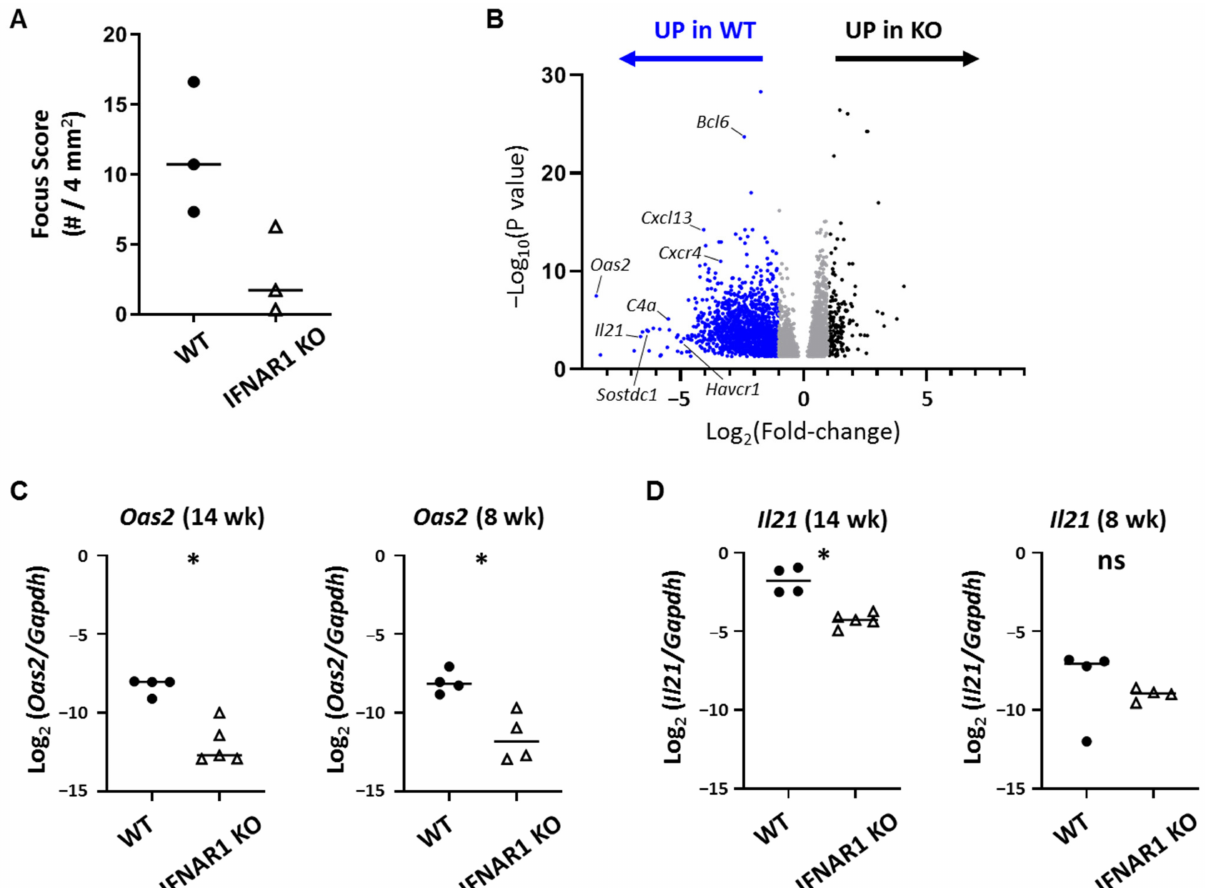
Figure 2. Type I IFN-dependent differential gene expression in lacrimal glands by RNA sequencing. ( A ) Quantitation of inflammation from WT and IFNAR1 KO NOD mouse lacrimal glands used for RNA sequencing studies. Focus scoring as described in Figure 1 legend. Symbols are individual mice, lines are medians. p = 0.1 by Mann-Whitney test. ( B ) Volcano plot of DE genes in lacrimal glands of NOD mice from (A) with genes up-regulated in WT or IFNAR1 KO as indicated above the graph. Dots represent individual genes with blue indicating at least 2-fold up-regulation in WT and black indicating at least 2-fold up-regulation in IFNAR1 KO. Gray genes are up-regulated with fold-change less than 2. Select genes up-regulated in WT are indicated. (C-D) Quantitation of Oas2 ( C ) or Il21 ( D ) gene expression in lacrimal glands of 14- or 8-week-old WT or IFNAR1 KO NOD mice ( n = 4–5 per group) by qPCR. Graphs show log-transformed ratios of each gene normalized to Gapdh . Symbols represent individual mice, lines are medians. p -values by Mann-Whitney test, * p < 0.05, ns p >